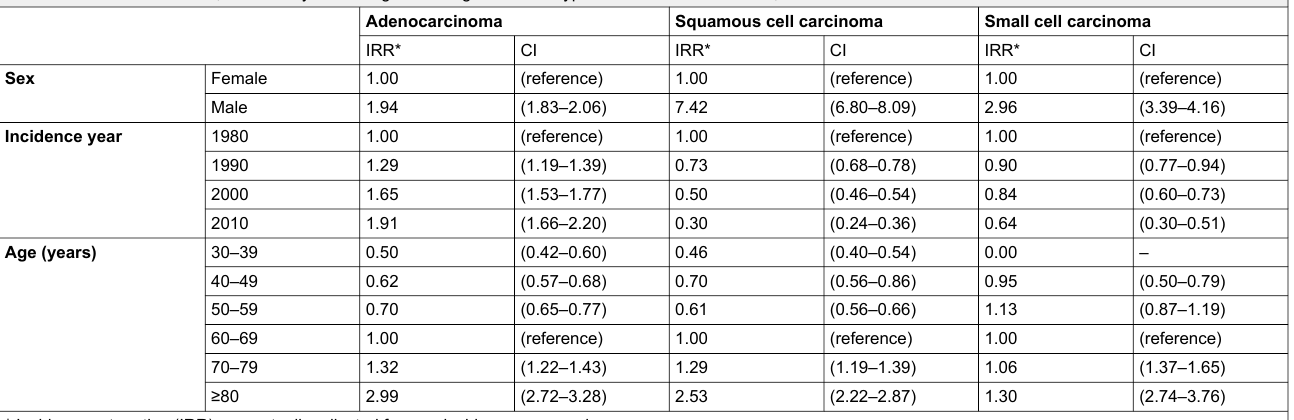
Table 2: Associations of sex, incidence year and age with lung cancer subtypes in the Canton of Zurich, 1980–2010.